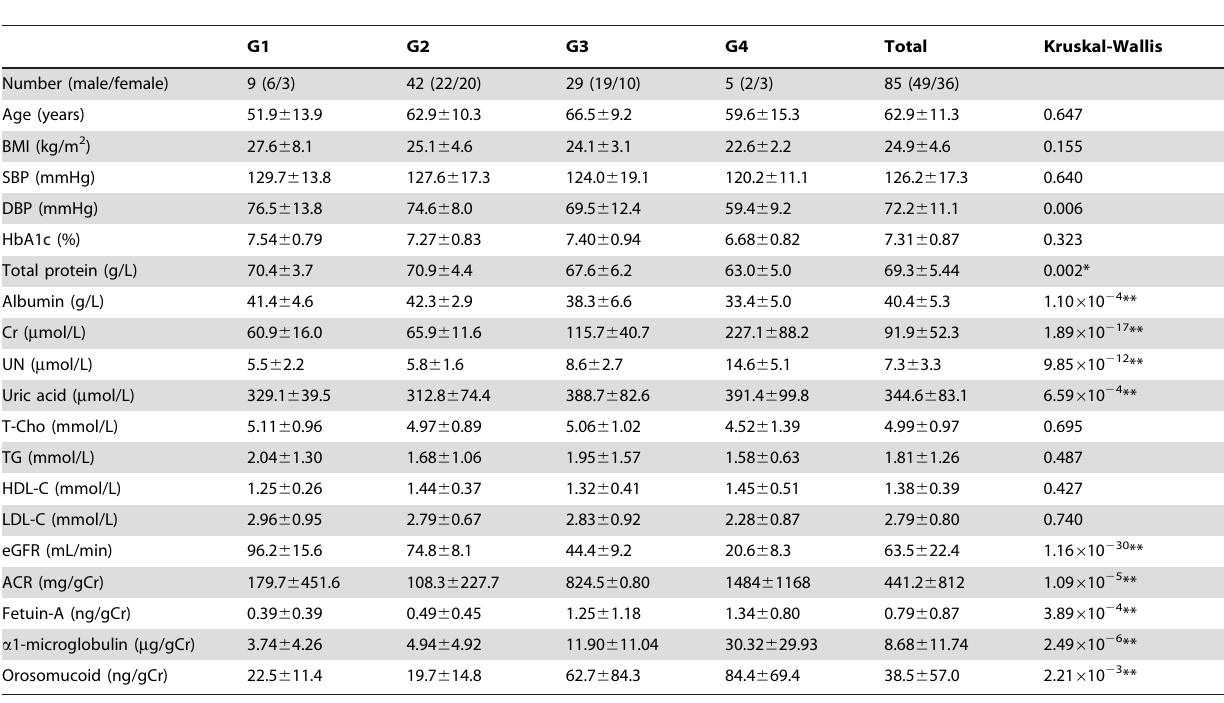
Table 5. Comparison of various parameters in glomerular filtration stages of chronic kidney disease in type 2 diabetes patients